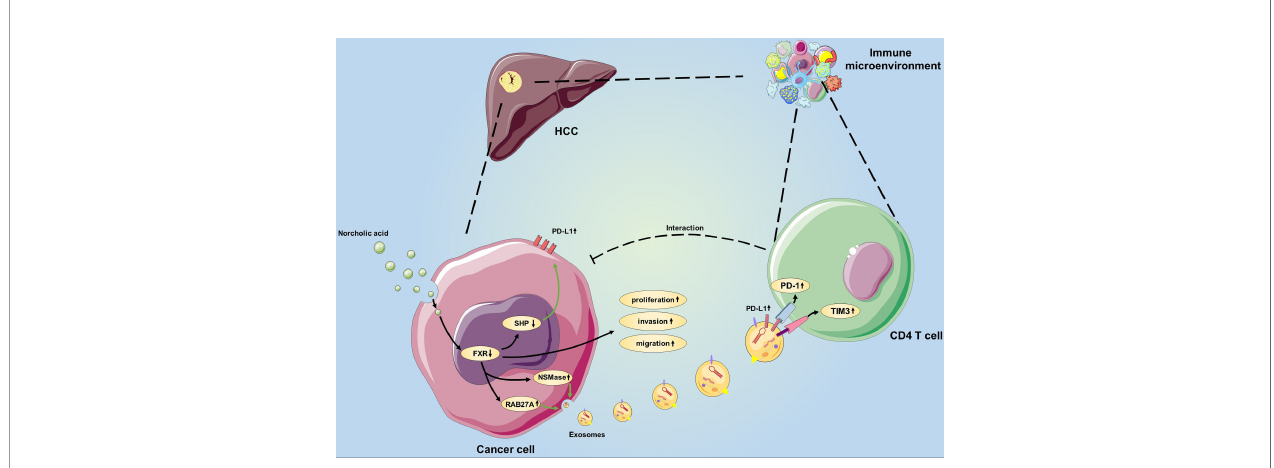
FIGURE 6 | Schematic showing the novel bile acid-mediated immune microenvironment in HCC progression. Considering our study results, we propose a model involving NorCA in HCC development. First, NorCA interacts with HCC cells to promote their ability to express PD-L1 through the FXR-SHP pathway. Second, NorCA enhances the synthesis and secretion of Exos from HCC cells by regulating NSMase and RAB27A. Third, N-Exos have the potential to create an immunosuppressive microenvironment by regulating the function of CD4 + T cell, thus creates bene fi cial conditions for tumor